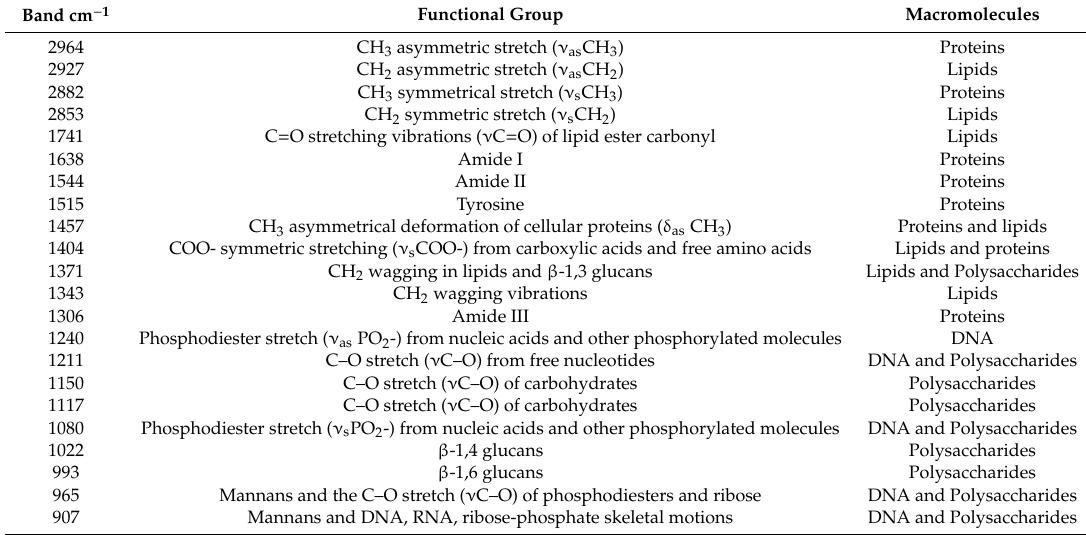
Figure 1. Attenuated total reflectance Fourier transform infrared (ATR-FTIR) spectra for Candida glabrata for fixed, untreated and washed samples that are: ( A ) raw data; one technical replicate per preparation method is shown; ( B ) mean pre-processed data for each preparation method, significant bands are labelled. Table 1. Main absorption bands and assignments for ATR-FTIR spectra of Candida glabrata [26–30]. Band cm −